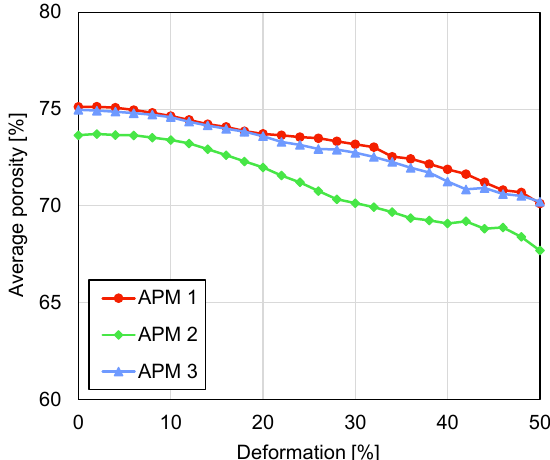
Figure 15. Average sample porosity plotted against deformation.